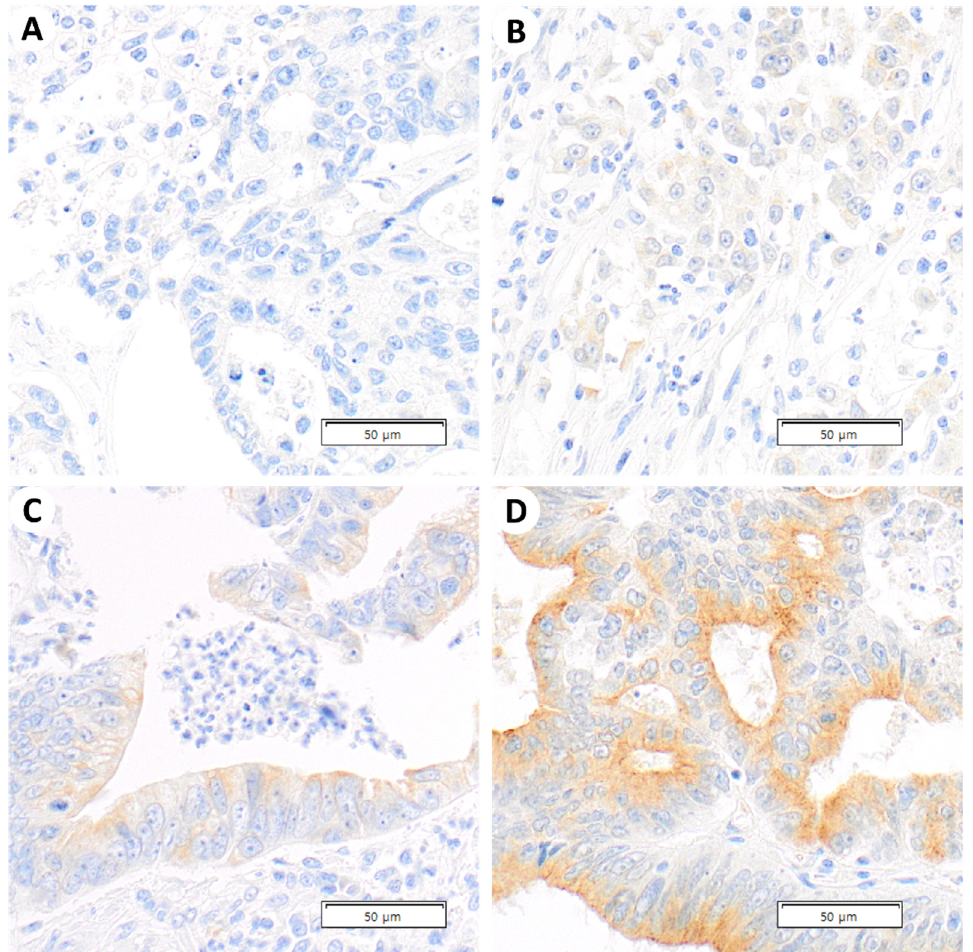
Figure 1. Representative photomicrographs of MTUS1 immunohistochemical stains. ( A ) Negative staining of poorly differentiated tumor cells ( × 400), ( B ) Weak positivity of poorly differentiated tumor cells ( × 400), ( C ) Moderate positivity of moderately differentiated tumor cells ( × 400), and ( D ) Strong positivity of well differentiated tumor cells ( × 400).